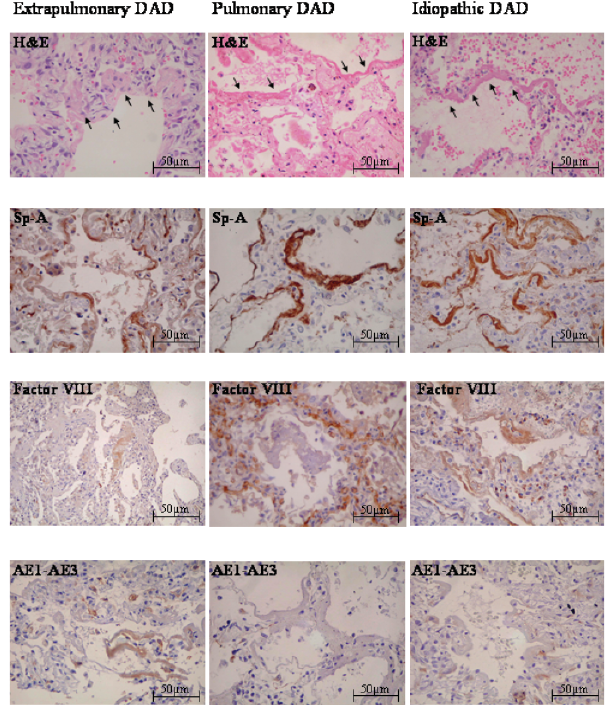
Figure 1 - Hyaline membrane (HM) (arrows) in 3 groups of diffuse alveolar damage (DAD)—extrapulmonary DAD, pulmonary DAD, and idiopathic DAD—is eosinophilic material lining alveolar surfaces that is presented in different ways depending on the group studied. Hyaline membrane appeared as a thick layer near basal membrane (in all groups), as a variable thin layer on the alveolar surface (in extrapulmonary DAD), and as interstitial fragments in cases in which there was less alveolar space (especially in idiopathic DAD and pulmonary DAD). Hyaline membrane of all 3 groups reacted with antibodies to surfactant apoprotein-A (SP-A). The extrapulmonary DAD group reacted with anti-Factor VIII in a few cases and was the only group that stained for AE1/AE3. The pulmonary DAD group had an intermediate stain level for factor VIII, but did not react with anti-AE1/AE3. All the HM of the idiopathic DAD group stained for Factor VIII and also did not react with